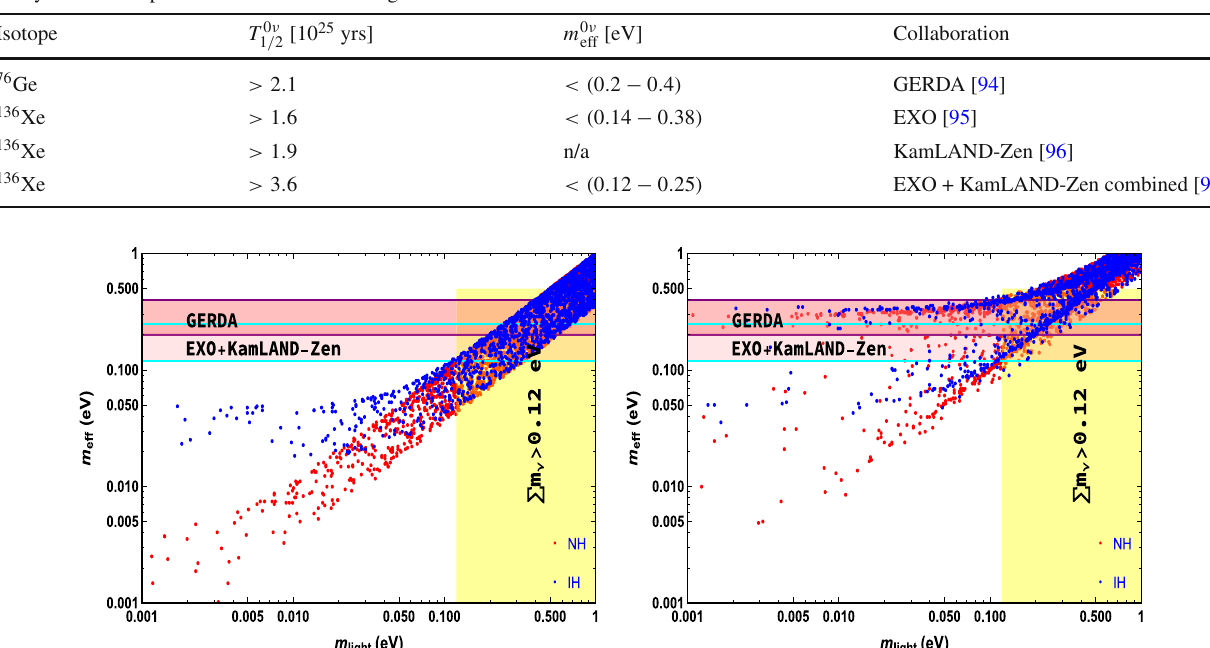
Fig. 10 Left Panel: Variation of effective Majorana mass as a func- tion of the lightest neutrino mass, m 1 (m 3 ) for NH (IH) due to stan- dard mechanism through light active Majoana neutrinos. Right Panel: The new physics contributions (in the presence of eV scale sterile-like neutrino, that falls in the experimental bound discussed in Table 6) to 0 νββ vs lightest neutrino mass, m 1 (m 3 ) for NH (IH). The NH